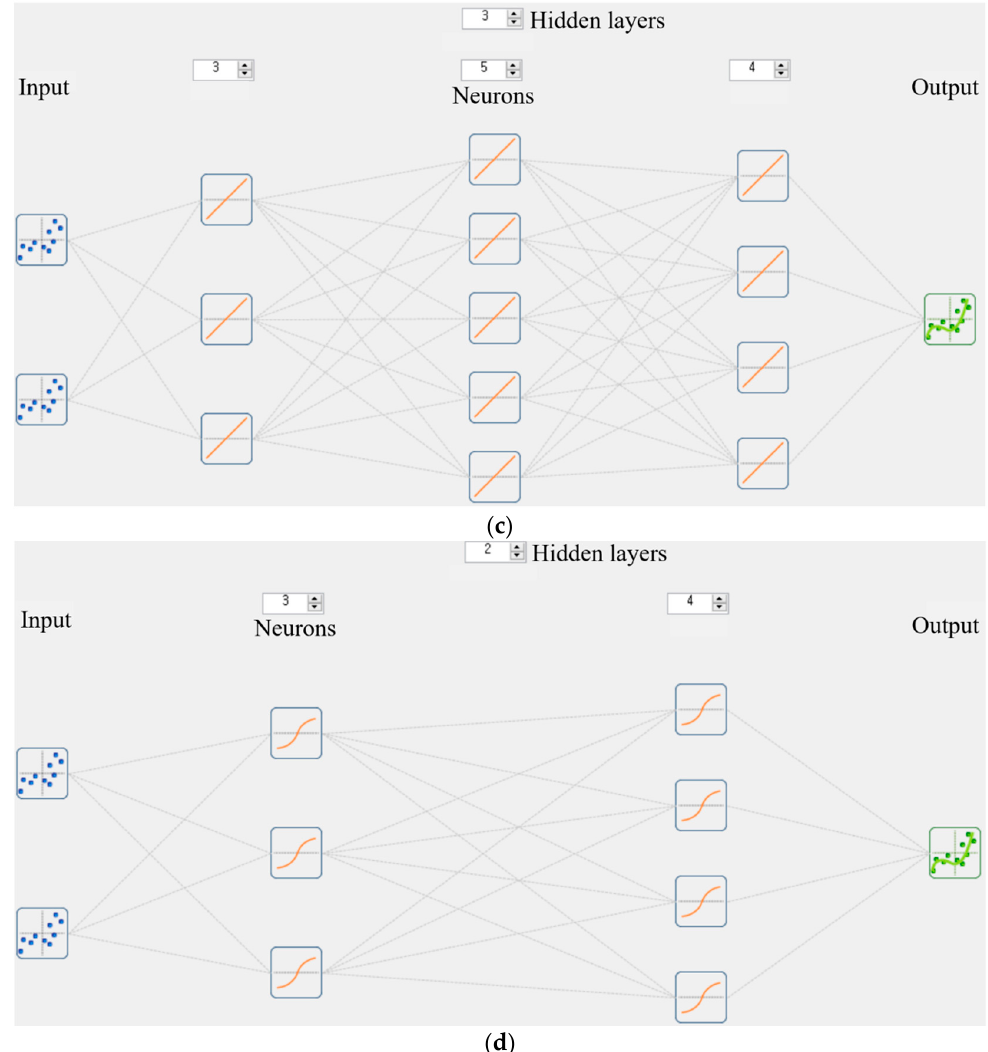
Figure 7. Metamodels using MLP: ( a ) torque; ( b ) THD of back EMF; ( c ) core loss; ( d ) peak to peak torque.